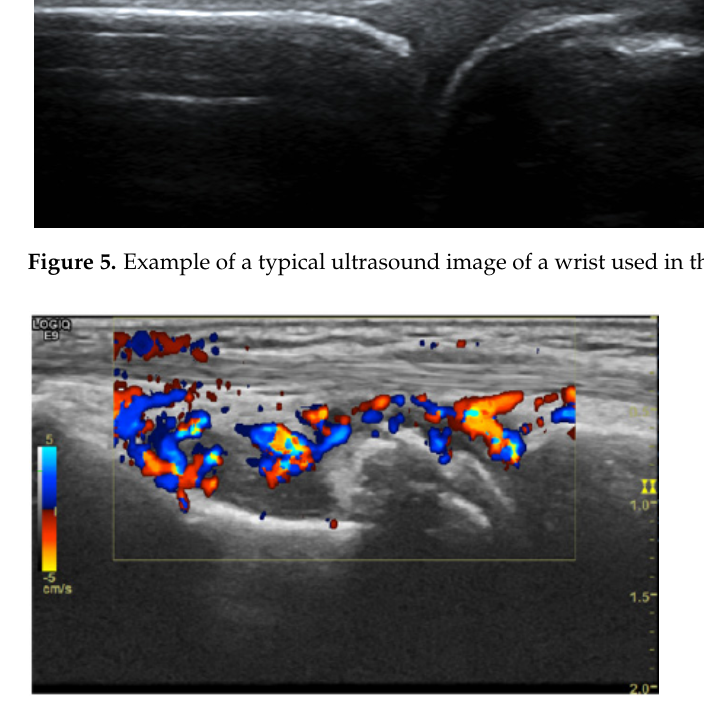
Figure 6. Example of an ultrasound color Doppler image of a wrist used in the database of [14].